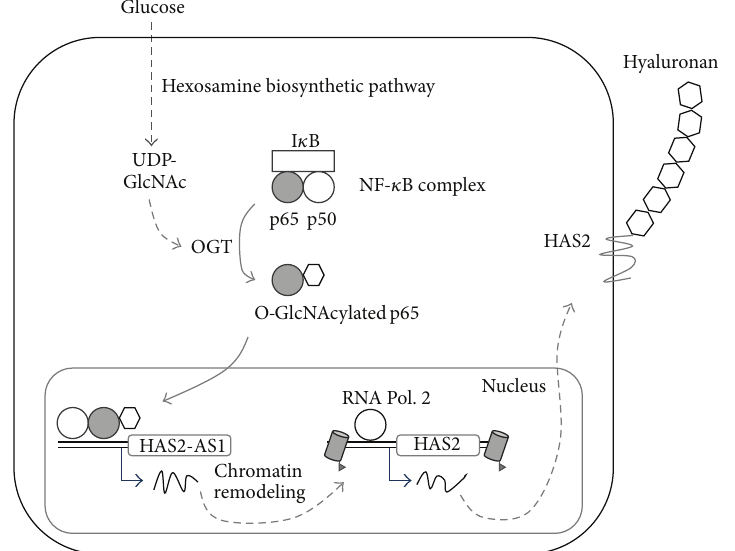
Figure 2: Nuclear control of HAS2 transcription by O-GlcNAcylation. In condition of glucose abundance, OGT modifies p65 by means of O-GlcNAcylation. Glycosylated p65 induces the transcription of HAS2-AS1 that, in turn, enhances HAS2 transcription. The mechanism through which HAS2-AS1 drives HAS2 transcription is complex and partially unknown. Natural antisense RNA can bind enzymes involved in epigenetic modifications. Recent evidences highlight that HAS2-AS1 is able to open chromatin structure around HAS2 promoter enhancing RNA polymerase 2 and other factors